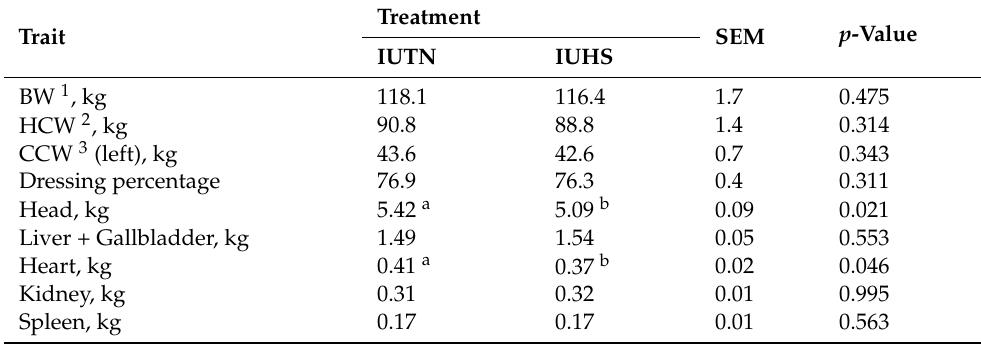
Table 1. Main effect of IUHS treatment on carcass and organ weights of gilts ( n = 10/treatment).